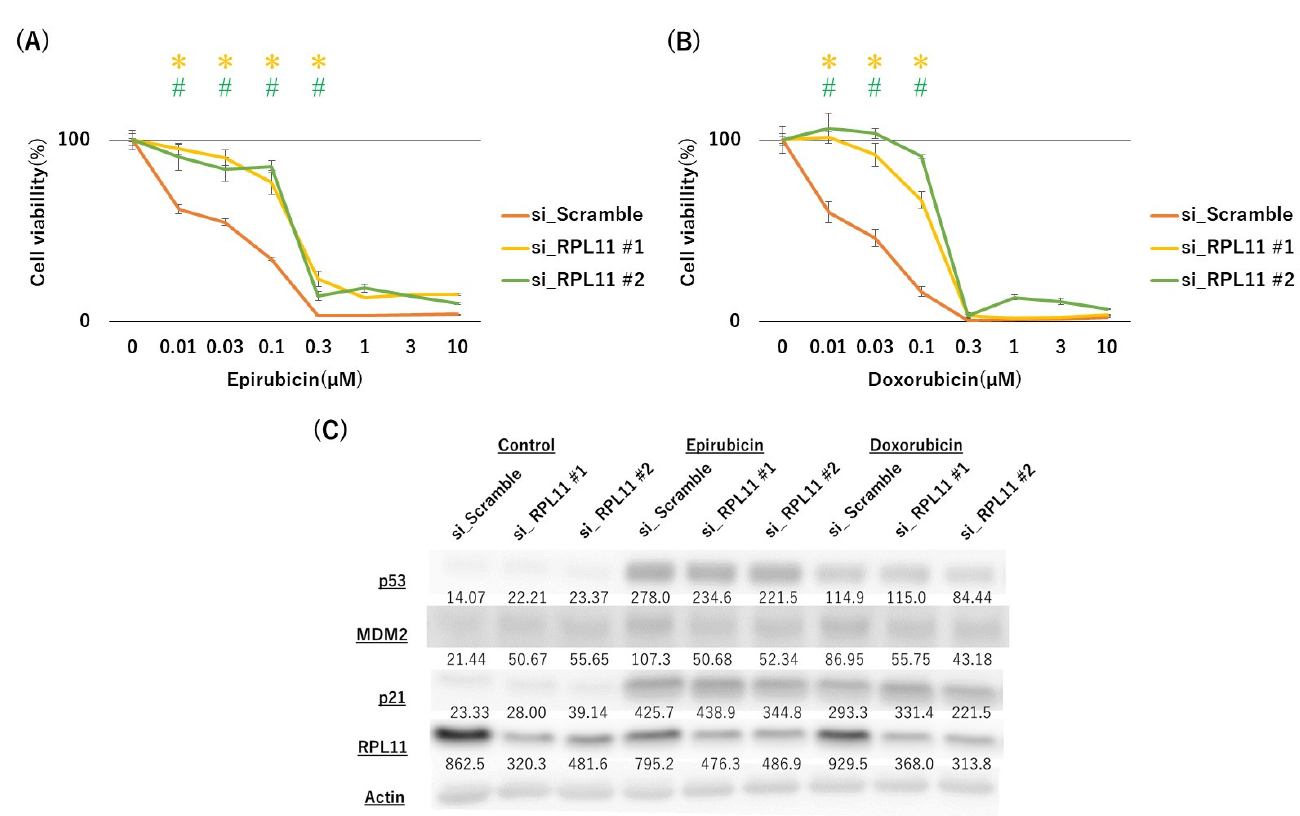
Figure 5. Effect of nucleolar stress response on sensitivity to anthracycline and p53 pathway activation by anthracycline drugs. JMU-RTK-2 cells were transfected with scramble, RPL11#1, and RPL11#2 siRNAs and treated with the indicated concentrations of drugs (( A ) Epirubicin and ( B ) Doxorubicin). After 3 days of culture, the number of surviving cells was measured using the MTT assay. ( C ) JMU-RTK-2 cells were transfected with scramble, RPL11#1, or RPL11#2 siRNA and treated with 0.3 µM Epirubicin, or 0.1 µM Doxorubicin. After 24 h of culture, the cell lysate was subjected to immunoblotting with antibodies against p53, MDM2, P21, RPL11, and Actin. Actin was used as a loading control. The numbers below the bands indicate the ratio of protein/actin determined using LuminoGraphII Image Analyzer with CS Analyzer 4 Software. * p < 0.05 vs.RPL11#1 siRNA group; # p < 0.05 vs. RPL11#2 siRNA group. Results represent independent three experiments.